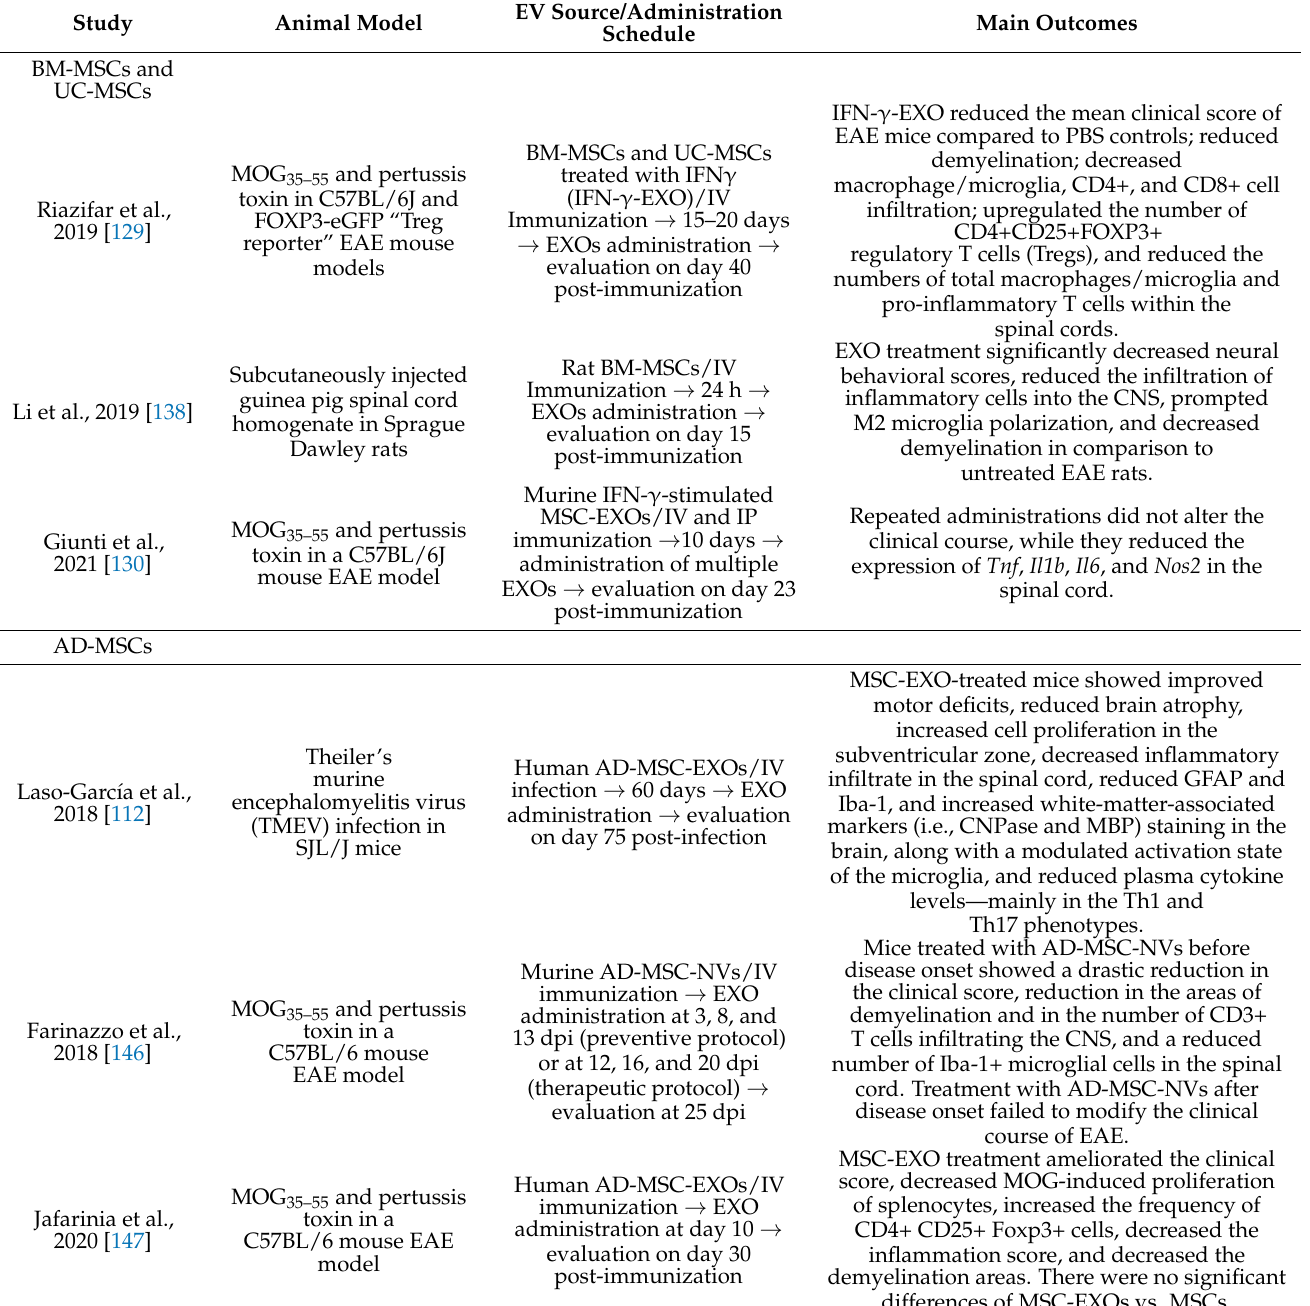
Table 1. Efficacy of MSC-EVs in preclinical models of demyelinating